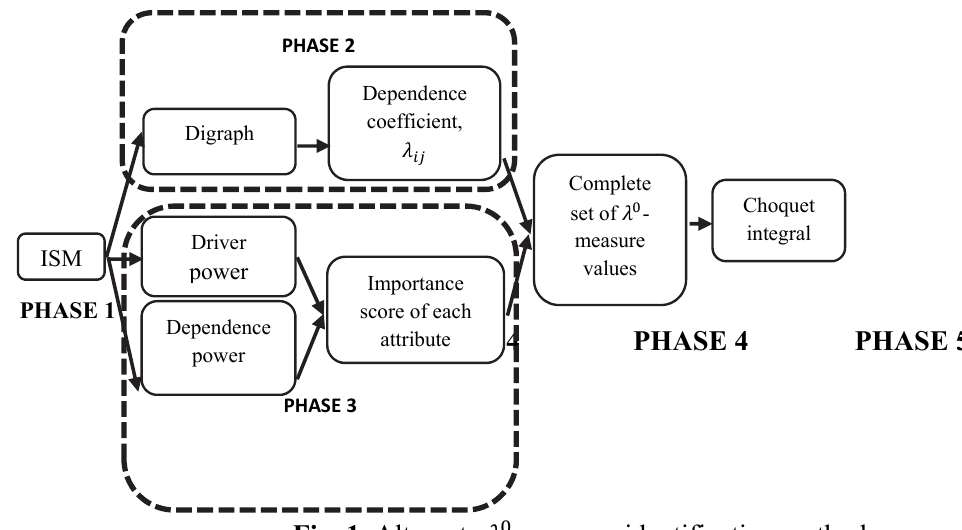
Fig. 1. Alternate (cid:2019) (cid:2868) -measure identification